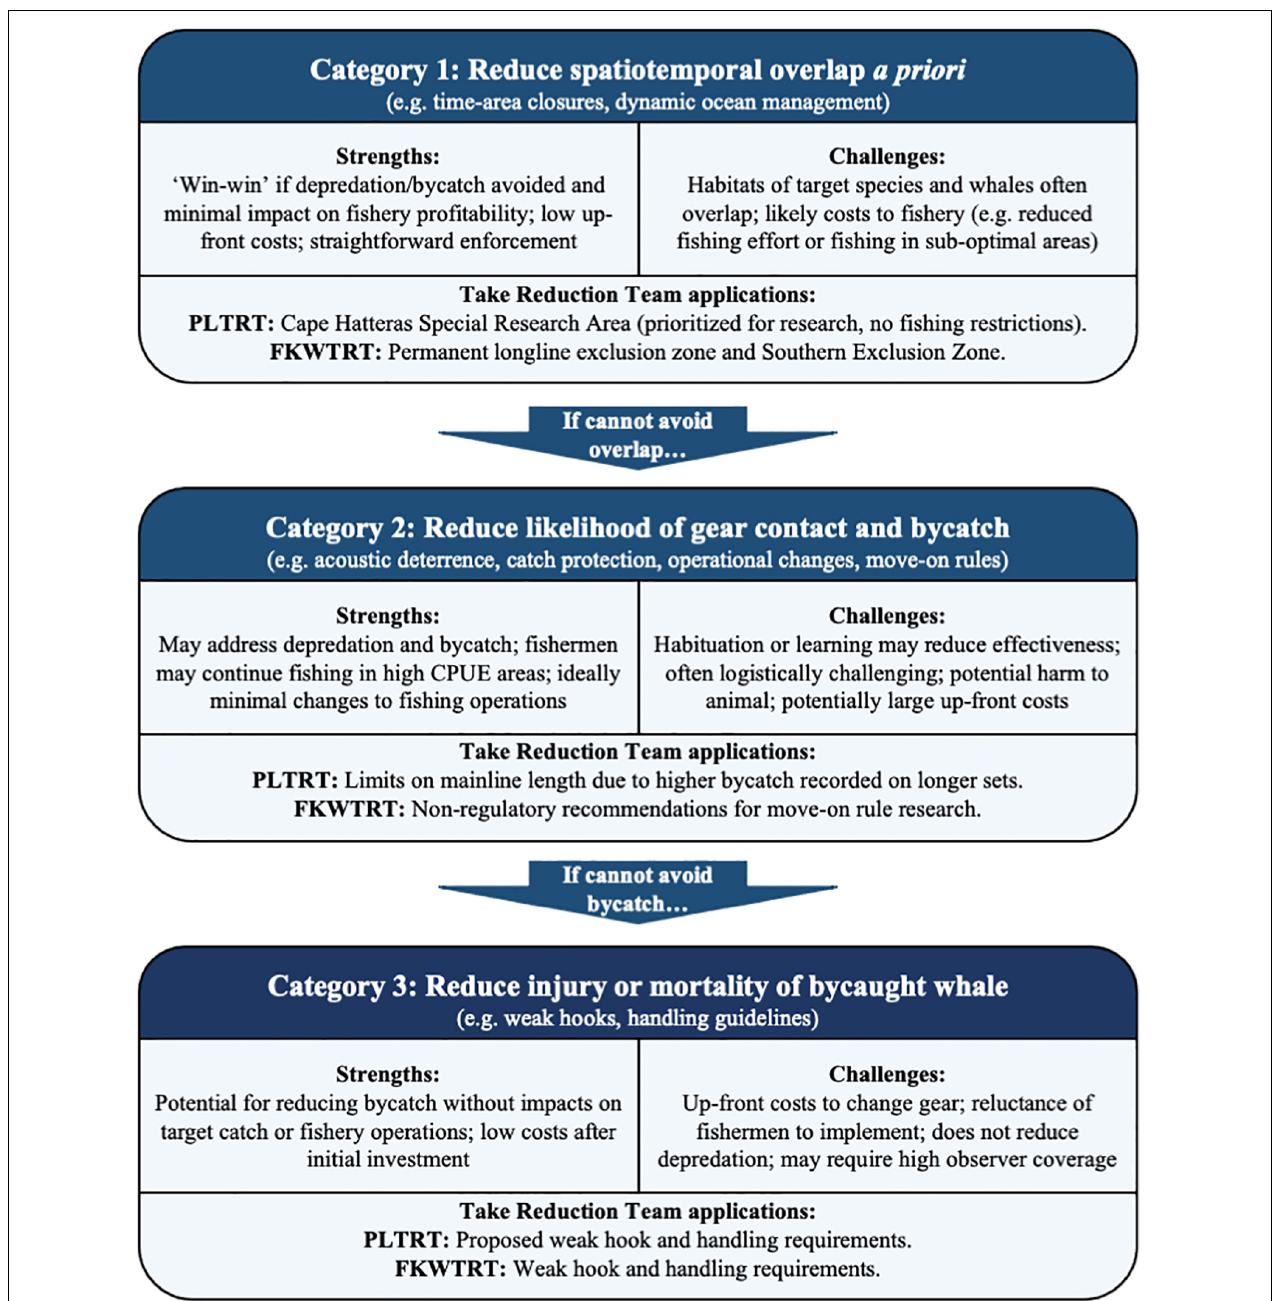
FIGURE 1 | Outline of the hierarchical categories of bycatch mitigation solutions available to longline fisheries affected by depredation; including the strengths and weaknesses of each category and specific applications implemented by each Take Reduction